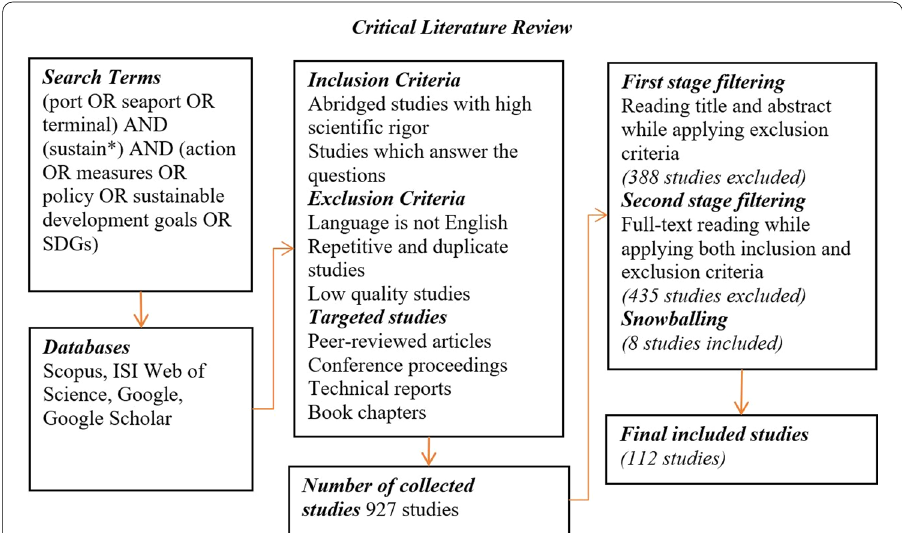
Fig. 1 Flowchart of the critical literature review steps including inclusion and exclusion criteria and filtering stages. Note Scientific rigor in the inclusion criteria is determined based on application of proper scientific methods which guarantee unbiased and well-established design, methodology, analysis, interpretation and